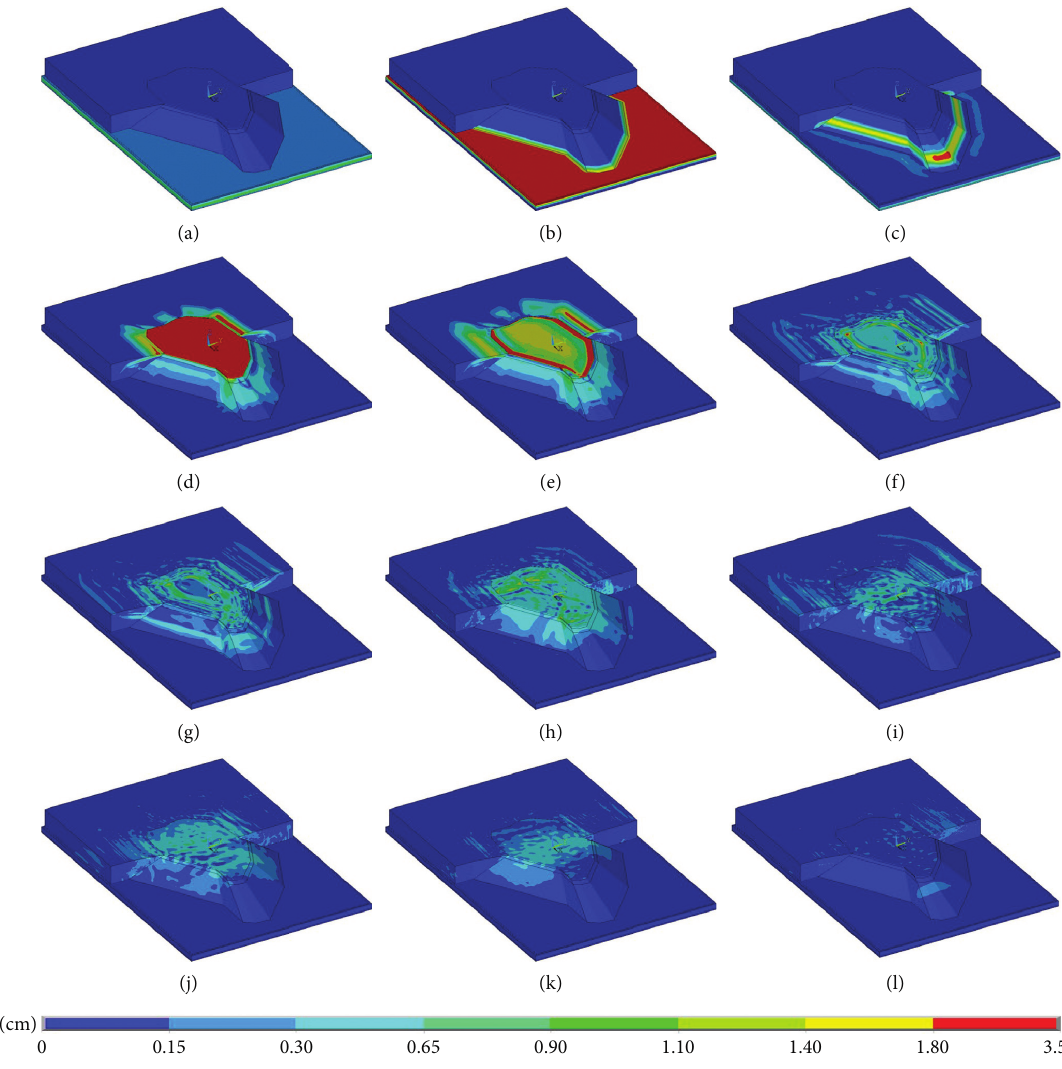
Figure 7: Displacement wave field in the 3D Zhubi Reef model under a vertically incident pulse wave: (a) t � 0.13s; (b) t � 0.18s; (c) t � 0.30s; (d) t � 0.60s; (e) t � 0.65s; (f) t � 0.90s; (g) t � 1.20 s; (h) t � 1.50s; (i) t � 2.00s; (j) t � 2.50s; (k) t � 3.50s; (l) t � 4.00